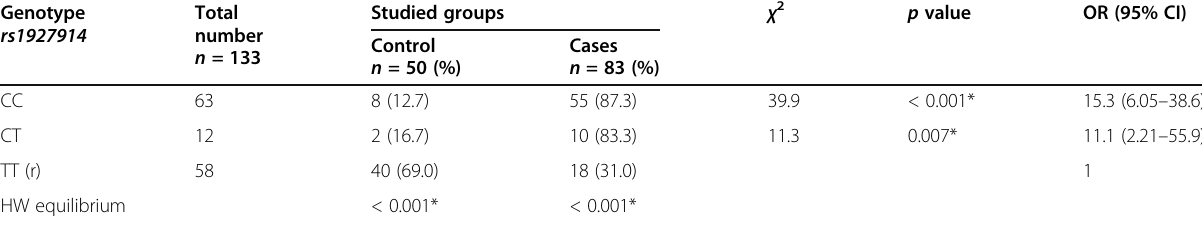
Table 2 rs1927914 genotype genetic polymorphism distribution between cases and control Genotype rs1927914